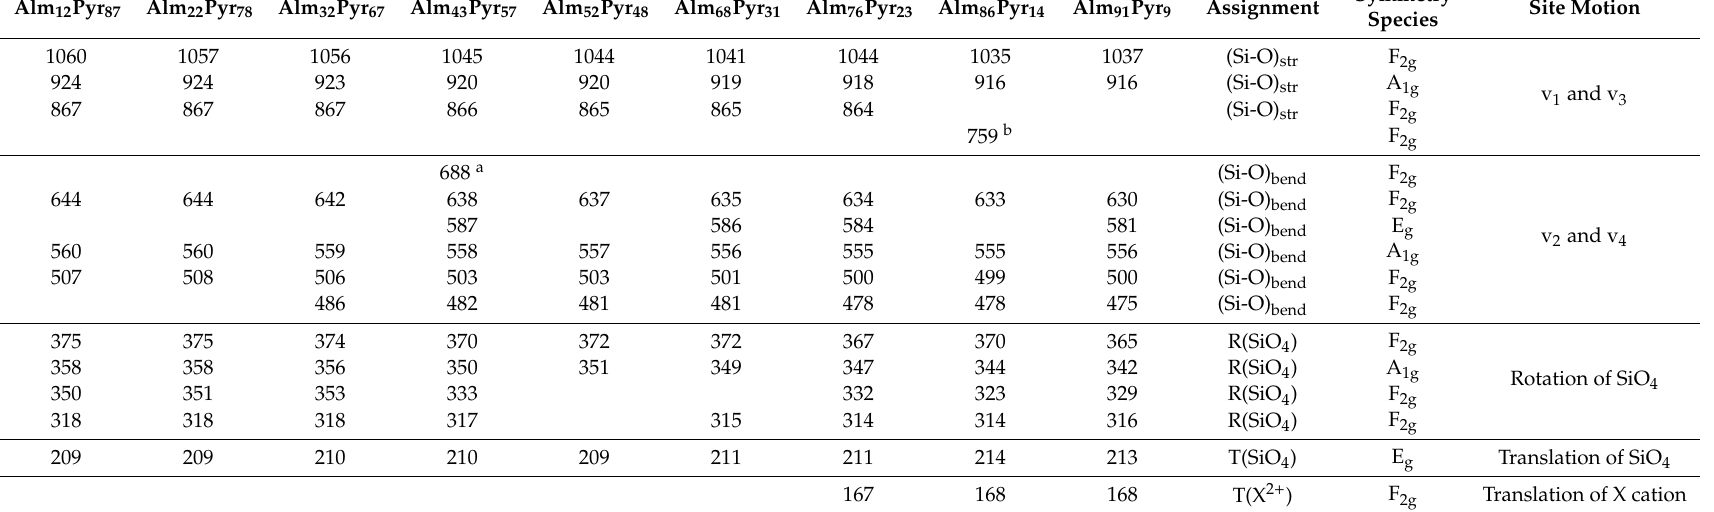
Table 4. Raman mode frequencies (cm − 1 ) of garnet solid solution along almandine-pyrope binary recorded at ambient